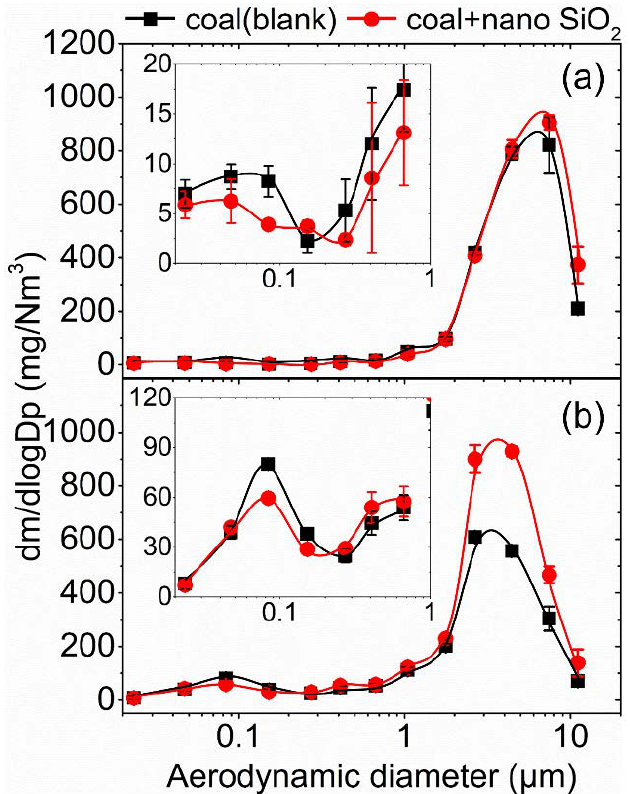
Figure 2. Particle size distributions of the PM 10 formed during the combustion of coals with/without nano SiO 2 addition: ( a ) SX; ( b ) WCW. Table 3. Mass yields of PM 0.1 , PM 0.1–2.5 , PM 2.5 , PM 2.5–10 and PM 10 and their reduction ratio after adding nano SiO 2 into coals SX and WCW.